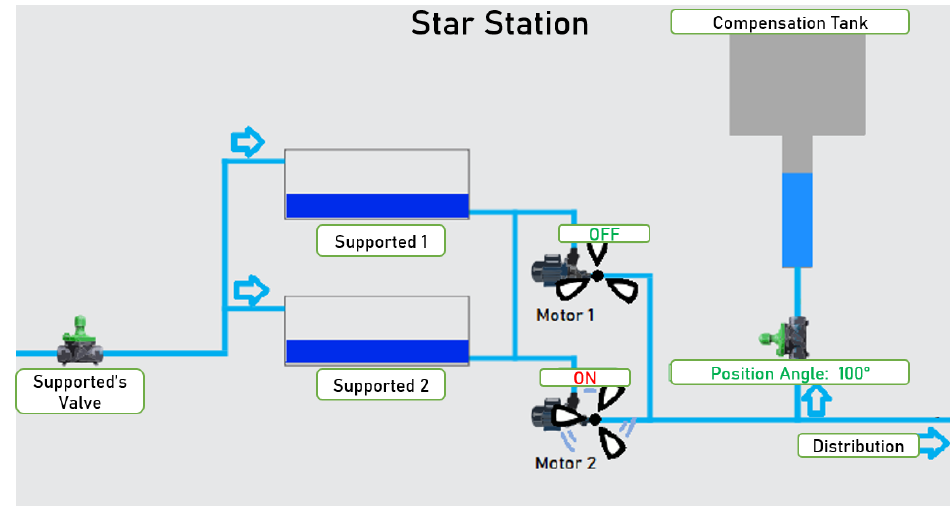
Figure 4. Star Station’s schematic. Source: Cagepa, 2021.